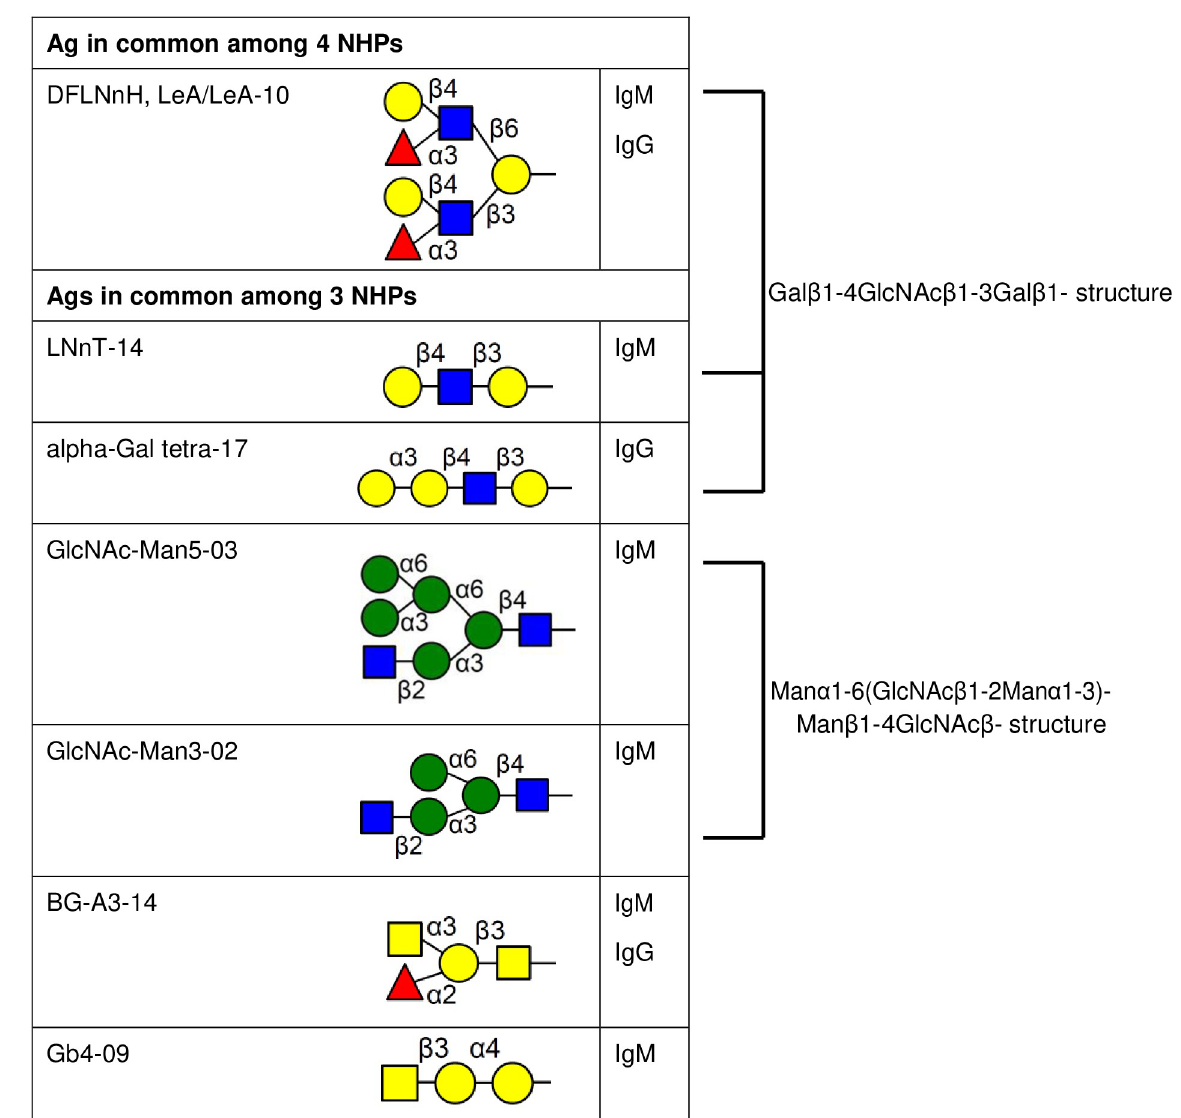
Fig 5. Carbohydrate antigens elicited in common among sensitized monkey